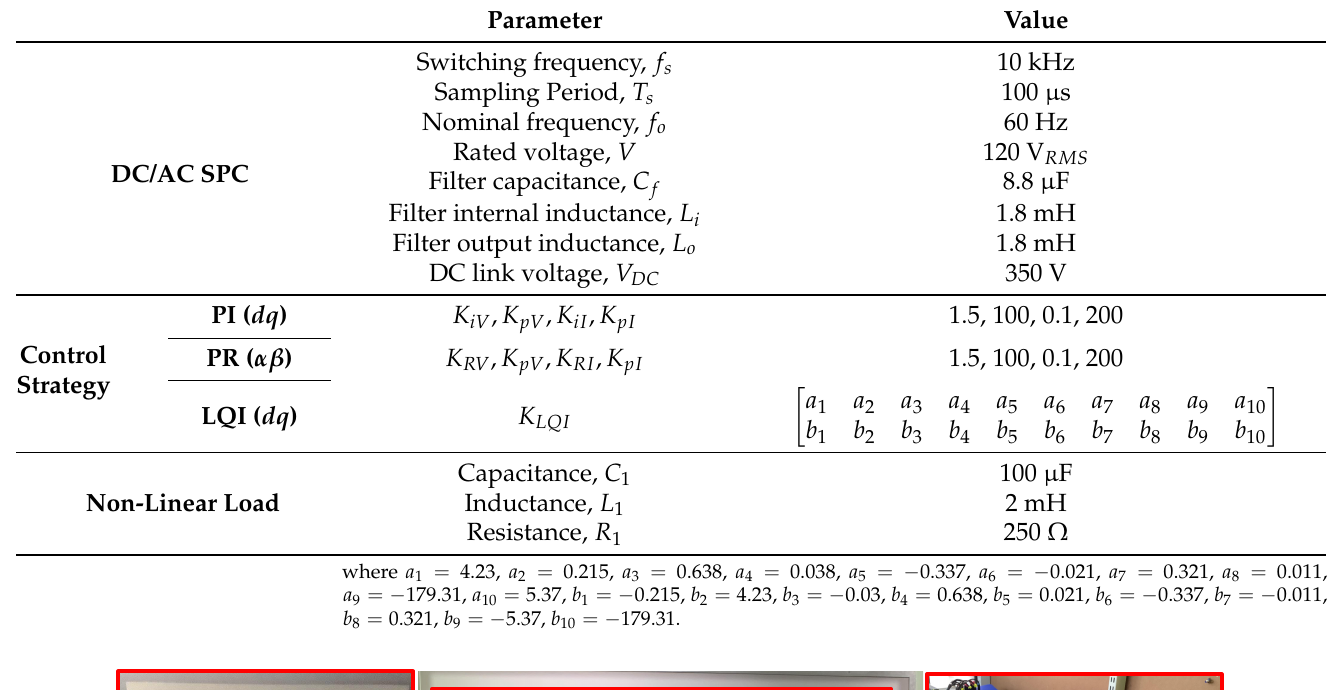
Table 3. Setup parameters.